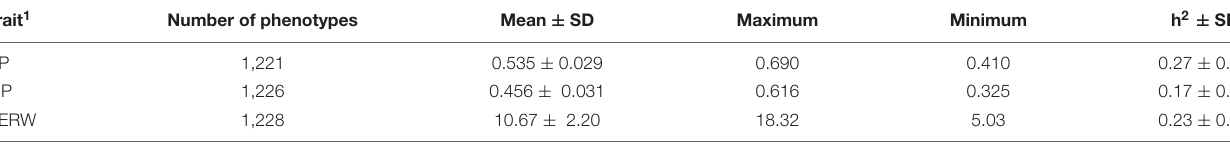
TABLE 2 | Statistical description and heritability estimation of three traits in Chinese Simmental beef cattle. Trait 1